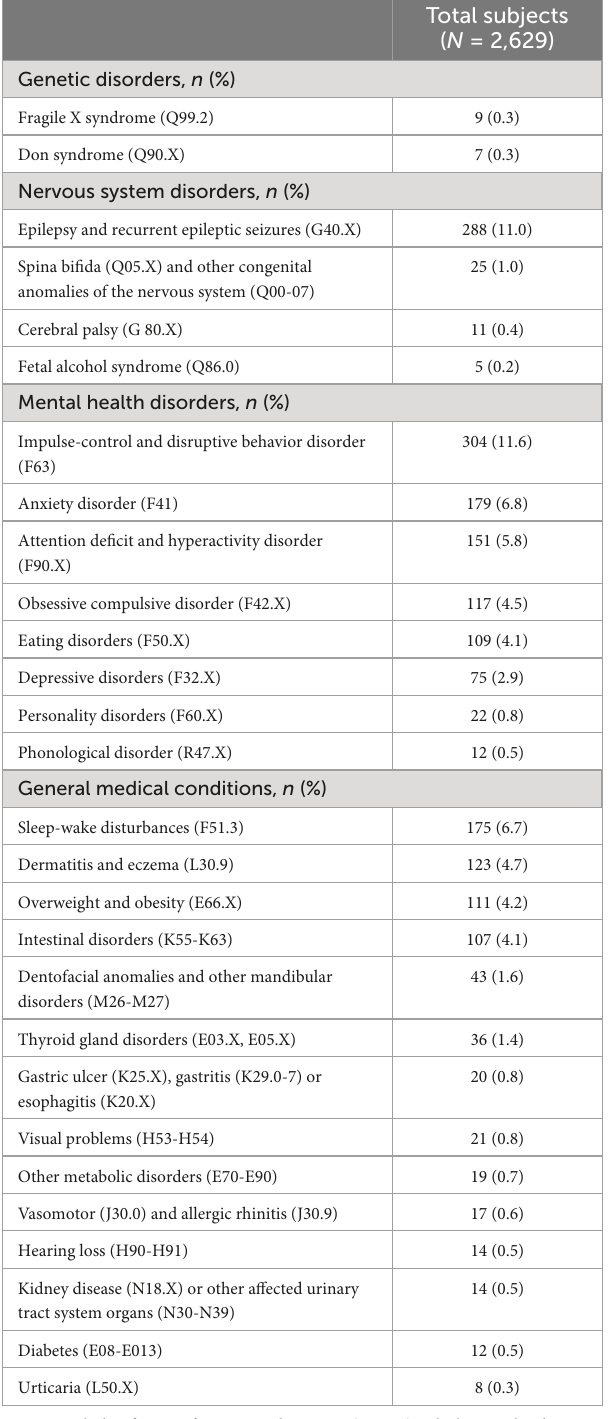
TABLE 2 Genetic, nervous system, and other comorbid